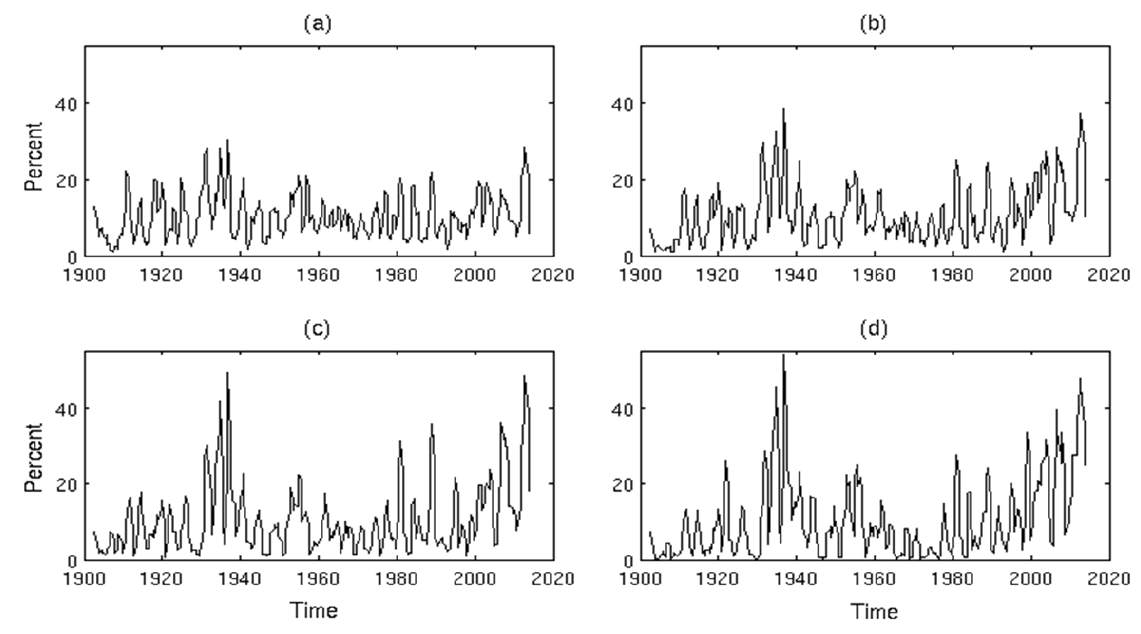
Figure 2. Time series of percent area of CONUS in which ( a ) SPI3 < −1.25; ( b ) SPEI3 < −1.25; ( c ) SVPD3 > 1.25; and ( d ) 3-month standardized surface air